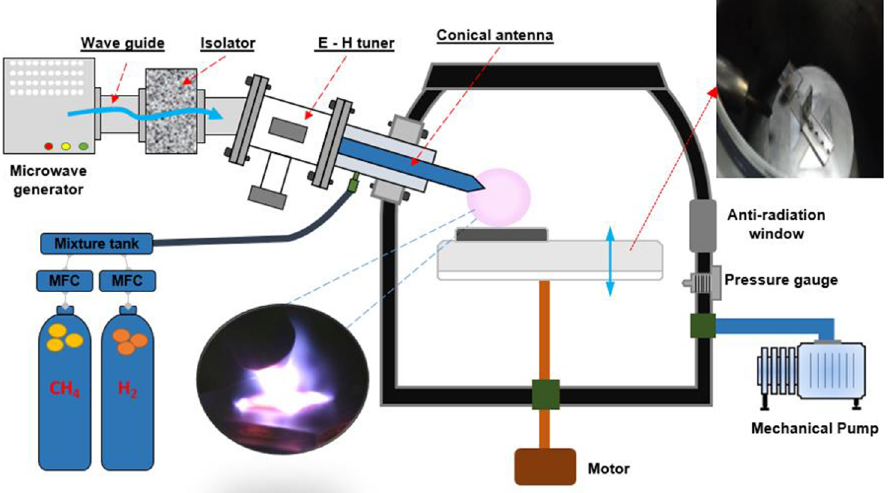
Figure 2. Schematics of the microwave plasma jet chemical vapor deposition (MPJCVD) system, in which the sample holder can be adjusted or modified.